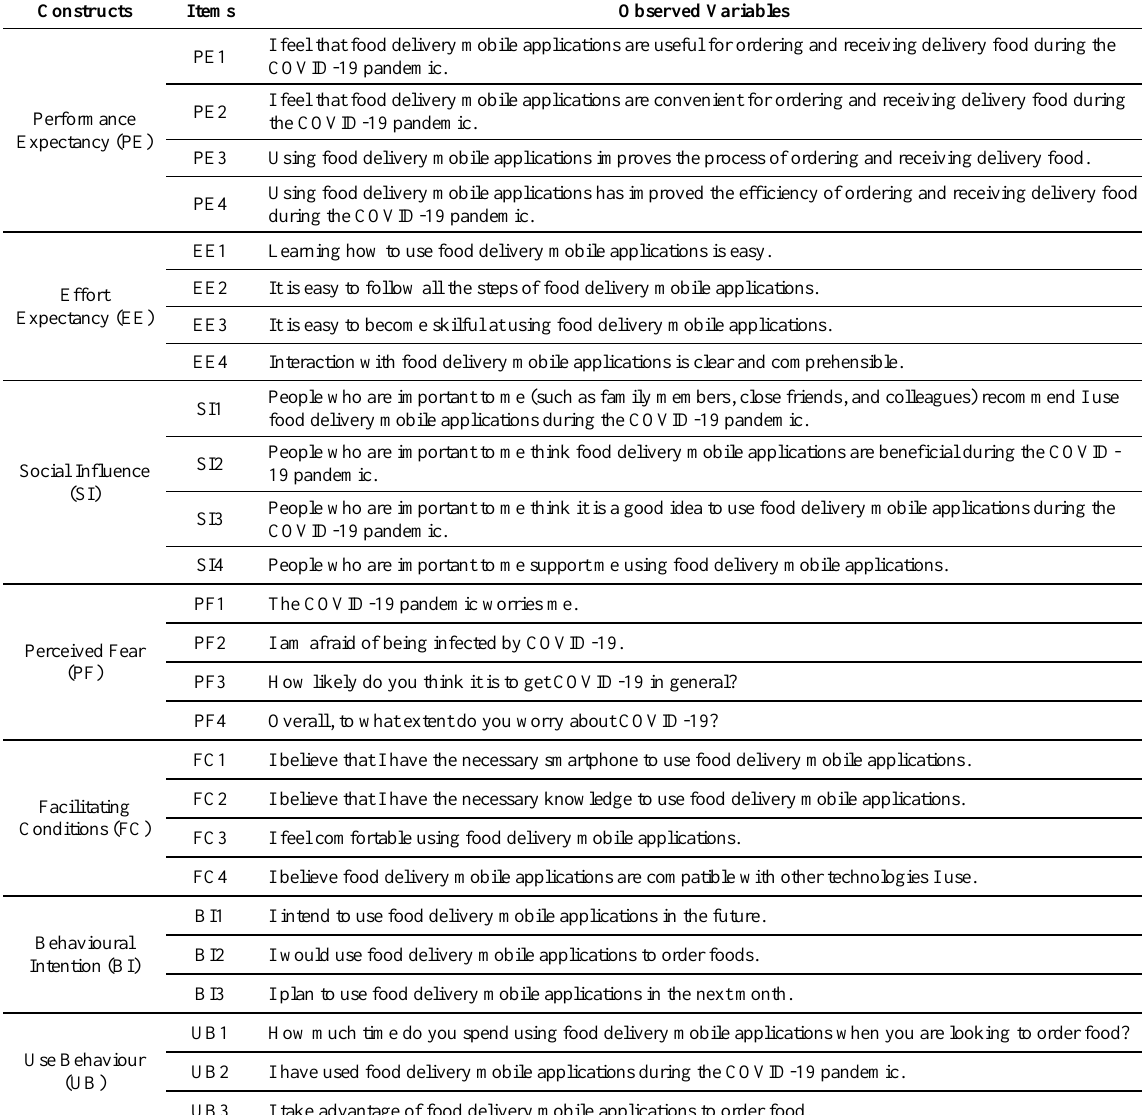
Table 1. Questionnaire constructs and variables.